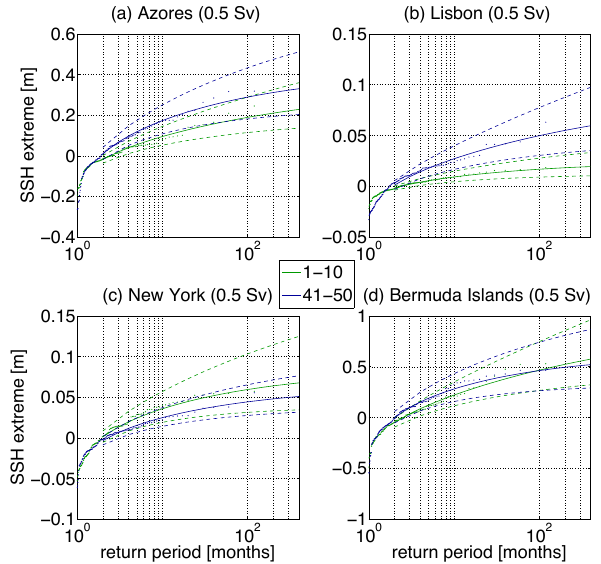
Figure 10. Generalised extreme-value (GEV) distribution fits to monthly maxima of detrended daily SSHP changes in the different coastal locations in the North Atlantic for the 0.5 Sv HR simulation. The extreme values are plotted as a function of return times using 10 years of data at the beginning of the simulation (green: years 1–10) and for a similar period at the end of the simulation (blue: 41–50). The dashed curves indicate the 95% confidence interval corresponding to the GEV fit. The locations considered are (a) Azores, (b) Lisbon, (c) New York and (d) Bermuda